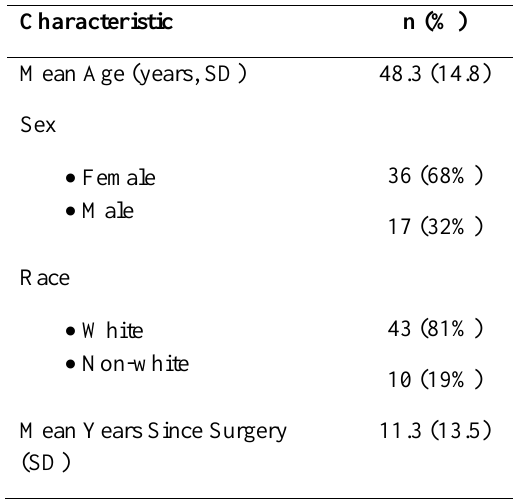
Table 1. Participant